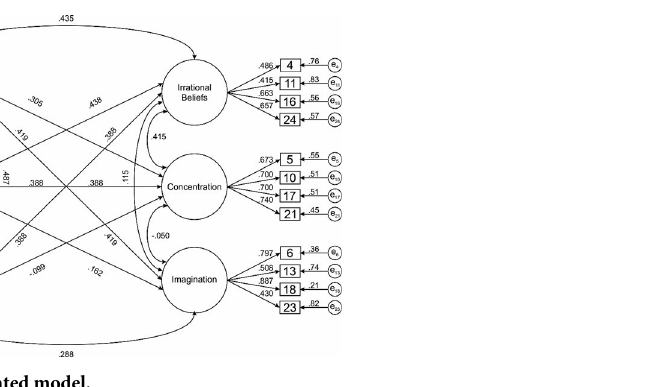
with the corrected score of their factor, and all contribute significantly to the alpha value of their factor.